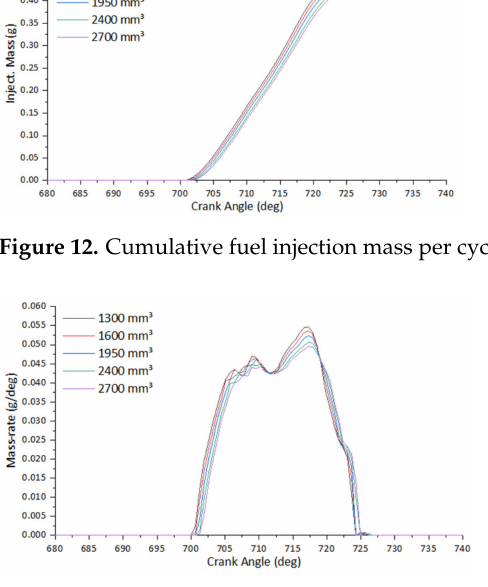
Figure 13. Fuel injection rate under varied valve volumes.